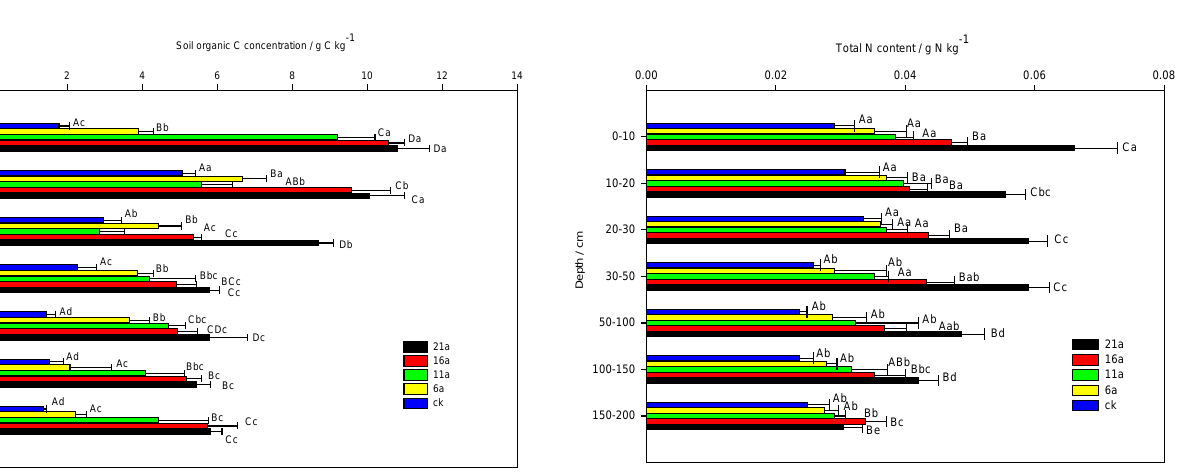
Figure 3. Variations in soil organic carbon concentration at different soil depths in different stand ages. Values are means ± SE. Different uppercase letters indicate significant differences in different stand ages; different lowercase letters indicate significant differences at different soil depths ( P <0.05).